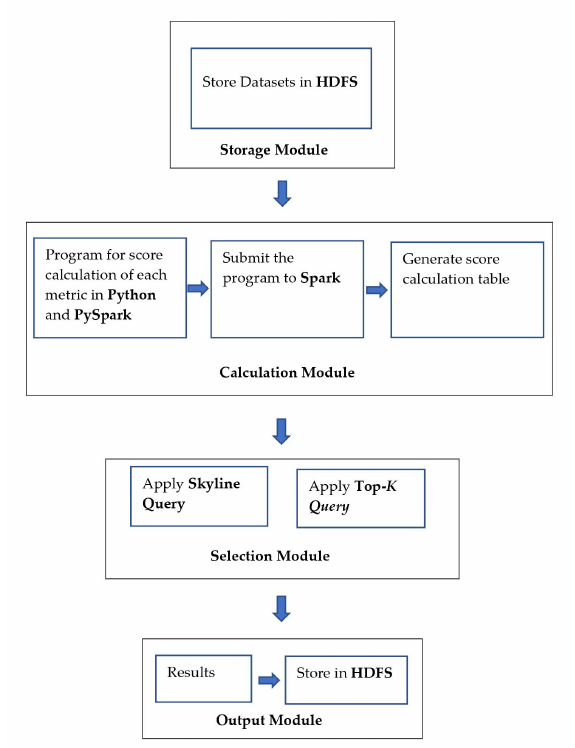
Figure 1. System architecture for finding influential people. HDFS, Hadoop Distributed File